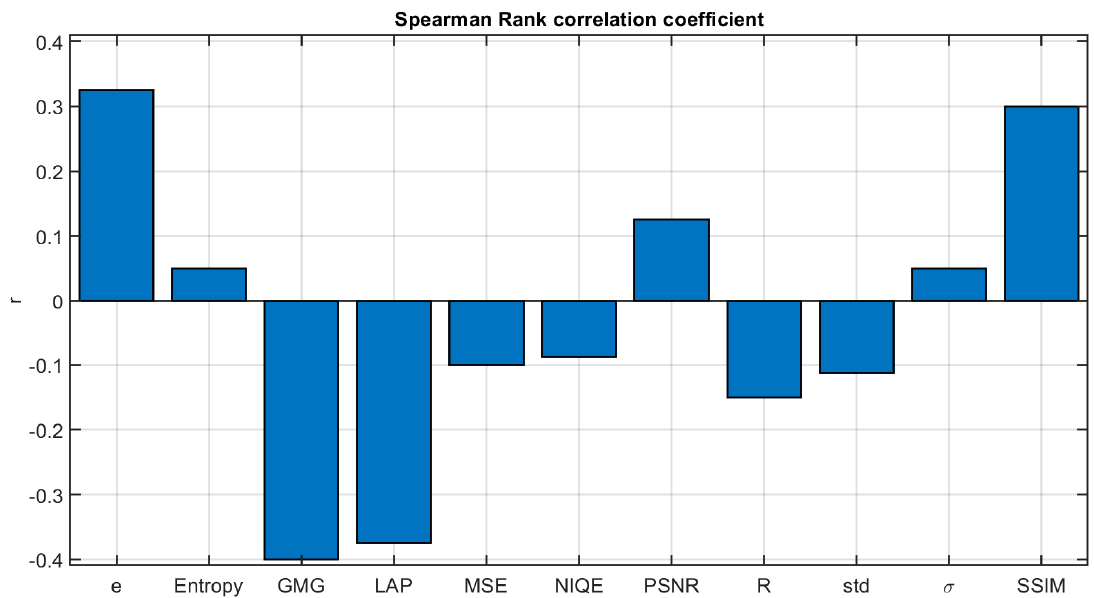
Figure 10. Average rank order correlation coefficient between observers’ answers to question 1 of the survey and the different metrics analyzed.